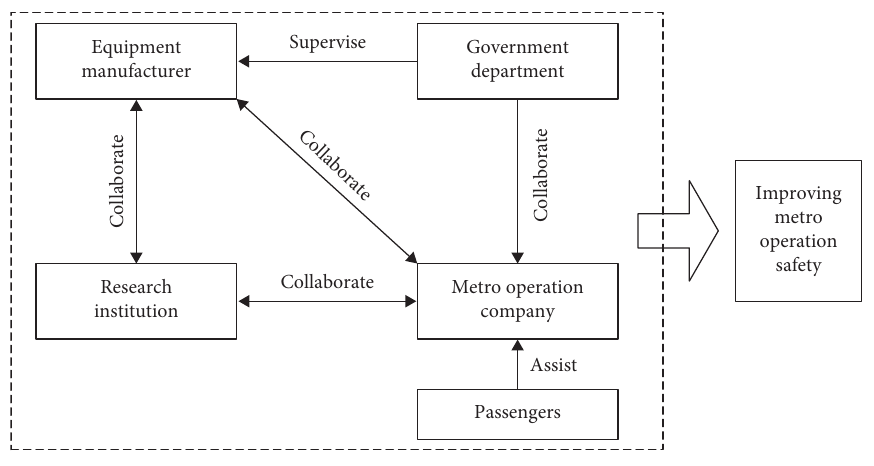
Figure 10: A proposed organization